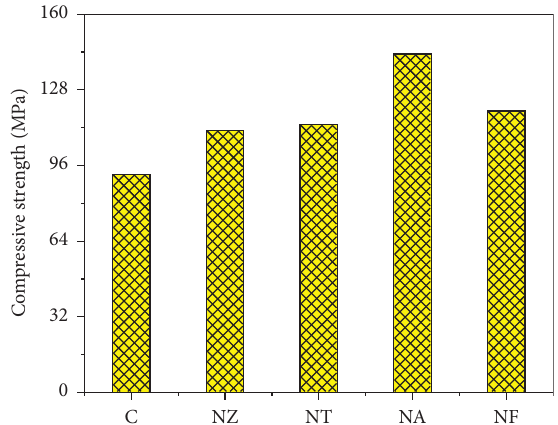
Figure 25: Compressive strength of different nanoparticles after 28 days [122].